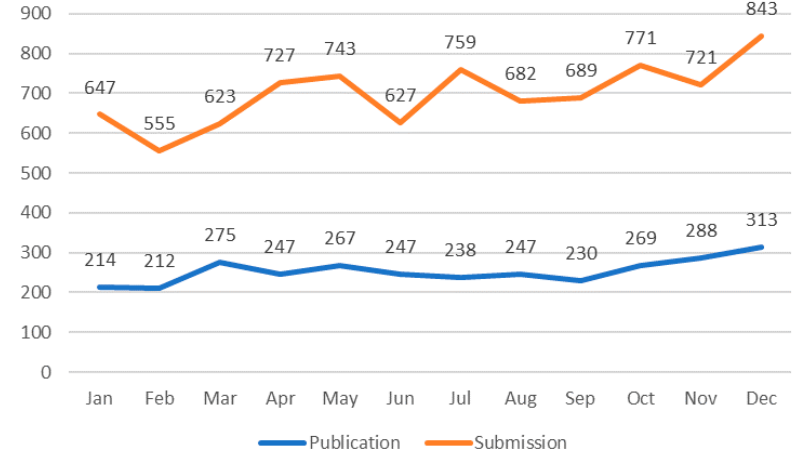
Figure 3. Number of monthly submissions and publications in 2019 for the Remote Sensing Open Access Journal of MDPI.